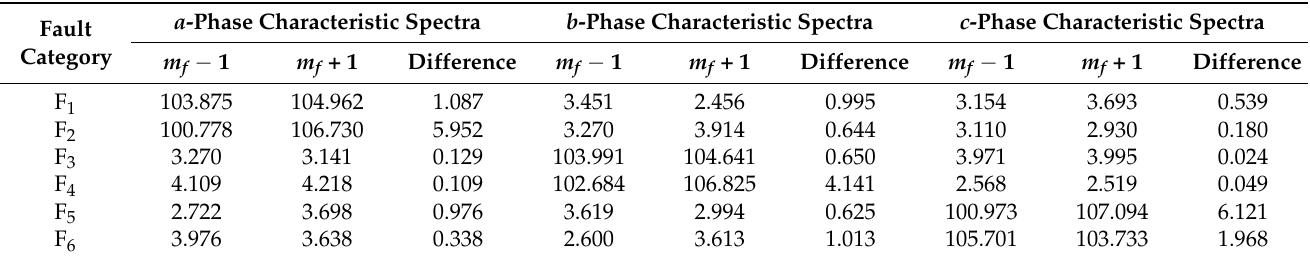
Table 3. Characteristic spectral data of the inverter at 85 Hz with different fault categories.